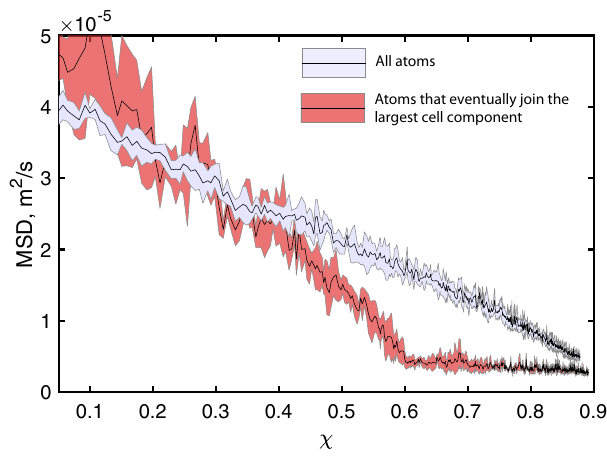
Fig. 5 Mean square displacement (MSD) of atoms in the EDDA system during curing. The fi gure demonstrates a separation of the network into two phases with respect to thermal fl uctuations. On average, the MSD of all atoms decreases with curing, however, the atoms that eventually join the largest connected component in the cell complex (identi fi ed at χ = 0.6) reach the terminal MSD earlier than the average atom in the